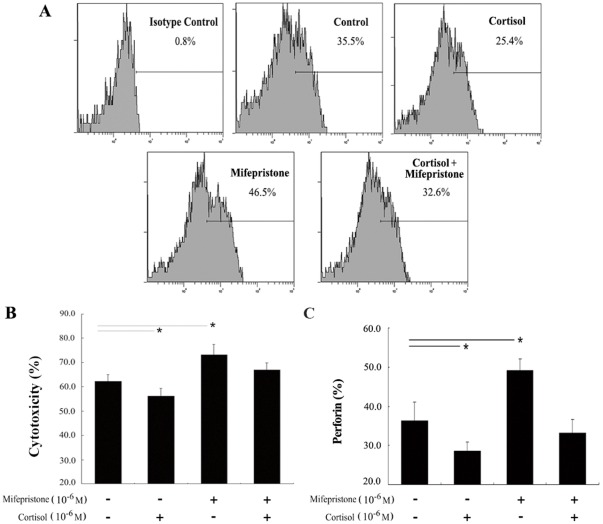
Effects of cortisol on mifepristone-induced uNK-cell cytotoxicity and perforin expression.Isolated uNK cells were treated with cortisol (1.0 µM) ± and mifepristone (1.0 µM) for 24 h. A, a representative flow cytometry result for perforin expression in different groups. B, results of uNK-cell cytotoxicity in different groups. C, data summary of flow cytometry results for perforin expression. The value is the percent of perforin-positive cells in the total number of uNK cells. Experiments were independently repeated 5 independent experiments. Data were analyzed using ANOVA and expressed as means ± SEM. *, P<0.05.